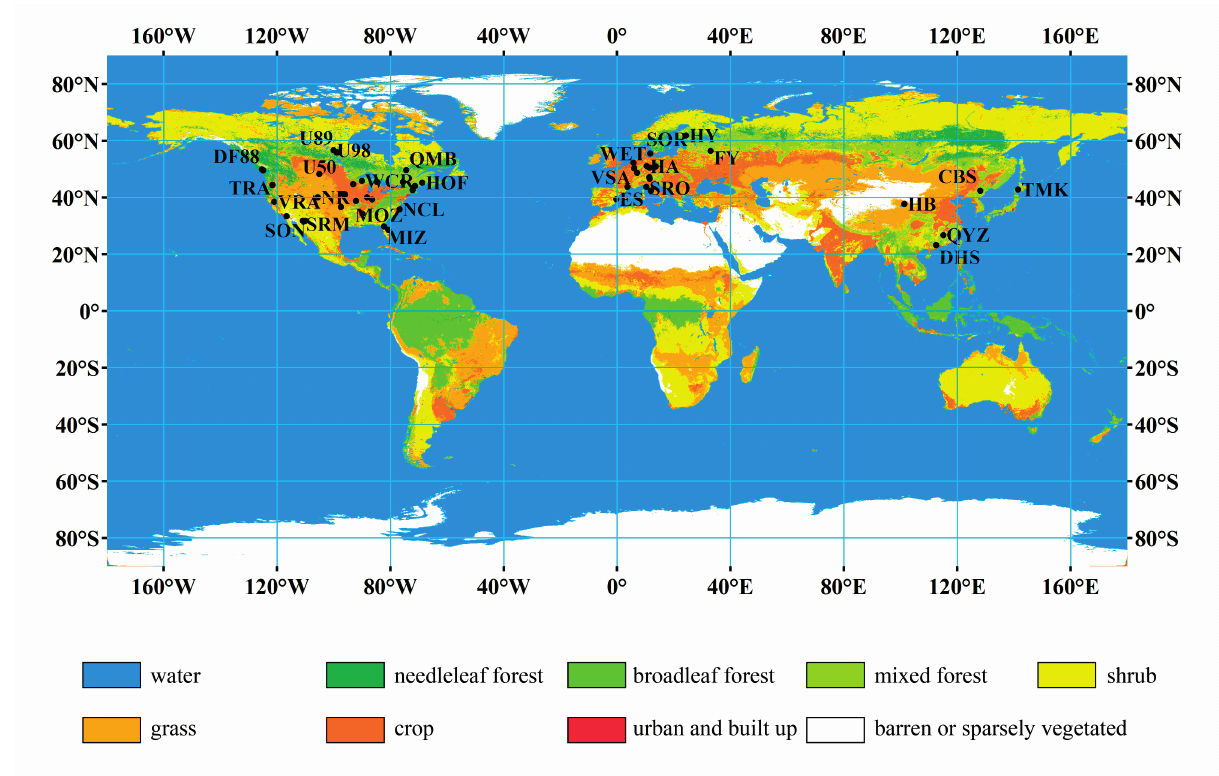
Figure 1. Distribution of all sites with data used for parameter optimization and validation in this study. The background is the MODIS global land cover product (MCD12C1) in 2003. Table 1. Name, location, vegetation type, and period of data used for each